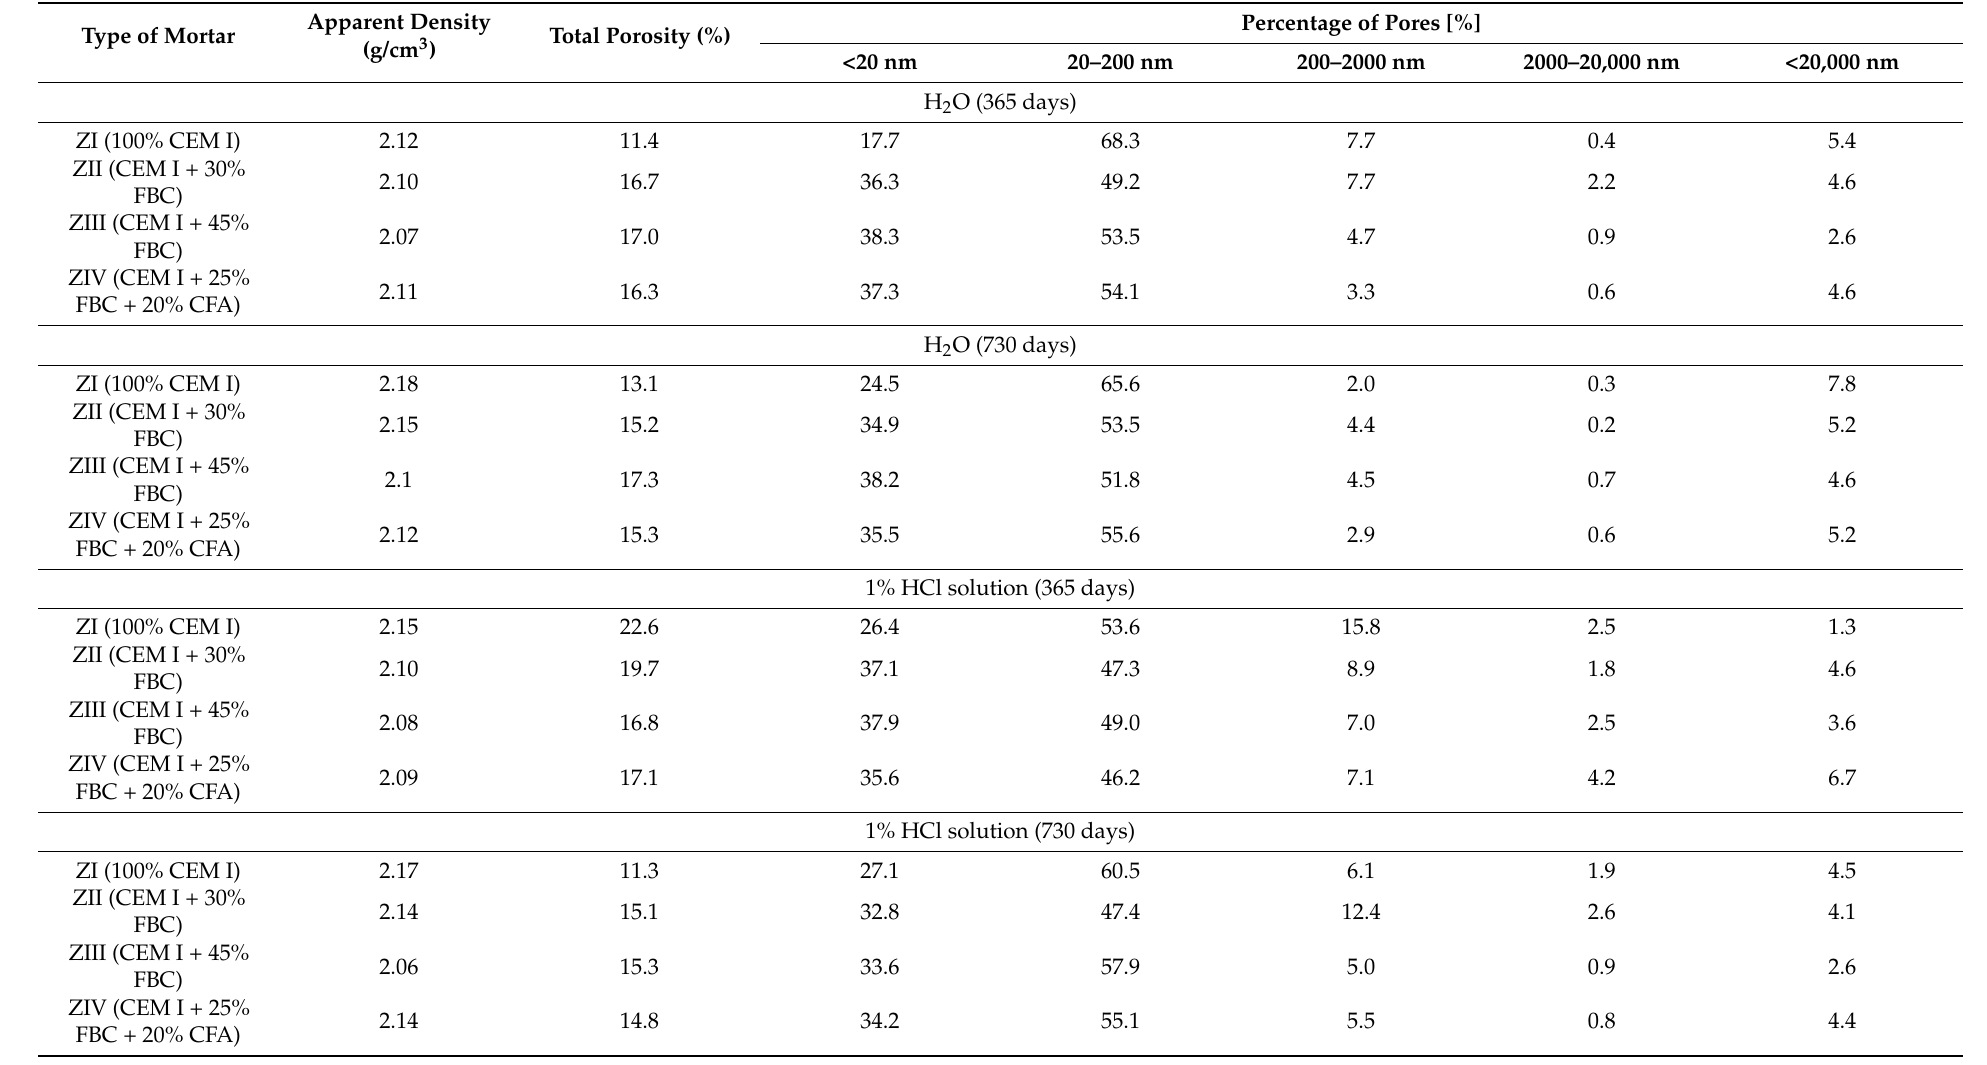
Table 10. Percentage content of pores in mortars cured in water and 1% HCl solution for 365